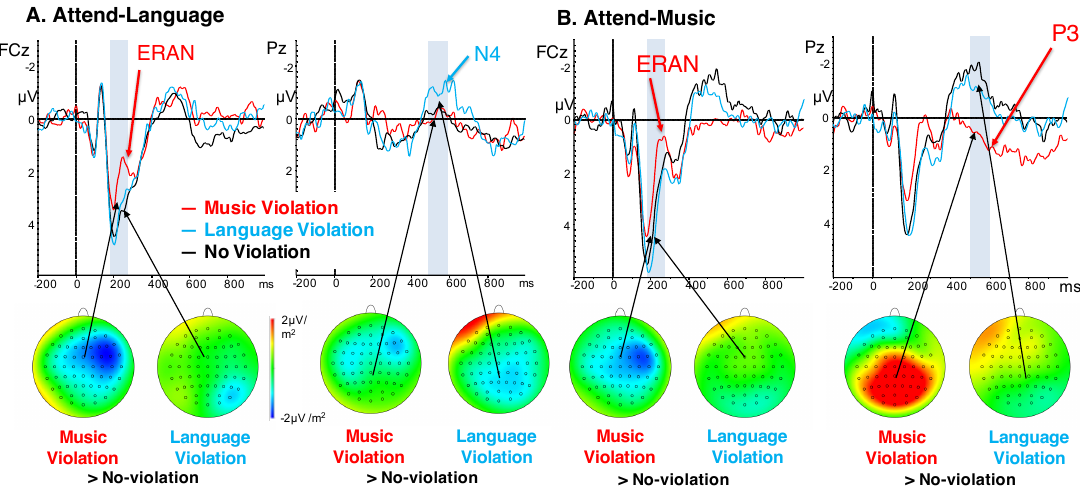
Figure 2. Overlays of ERPs from each condition with topographic maps of the di ff erence wave between violation and no-violation conditions. Music syntax violation condition is shown in red and linguistic syntax violation condition is shown in blue. Black represents a condition when neither stimulus was violated. Topographic plots show di ff erence waves between music violation and no-violation, or between language violation and no-violation. ( A ) When attending to language. ( B ) When attending to